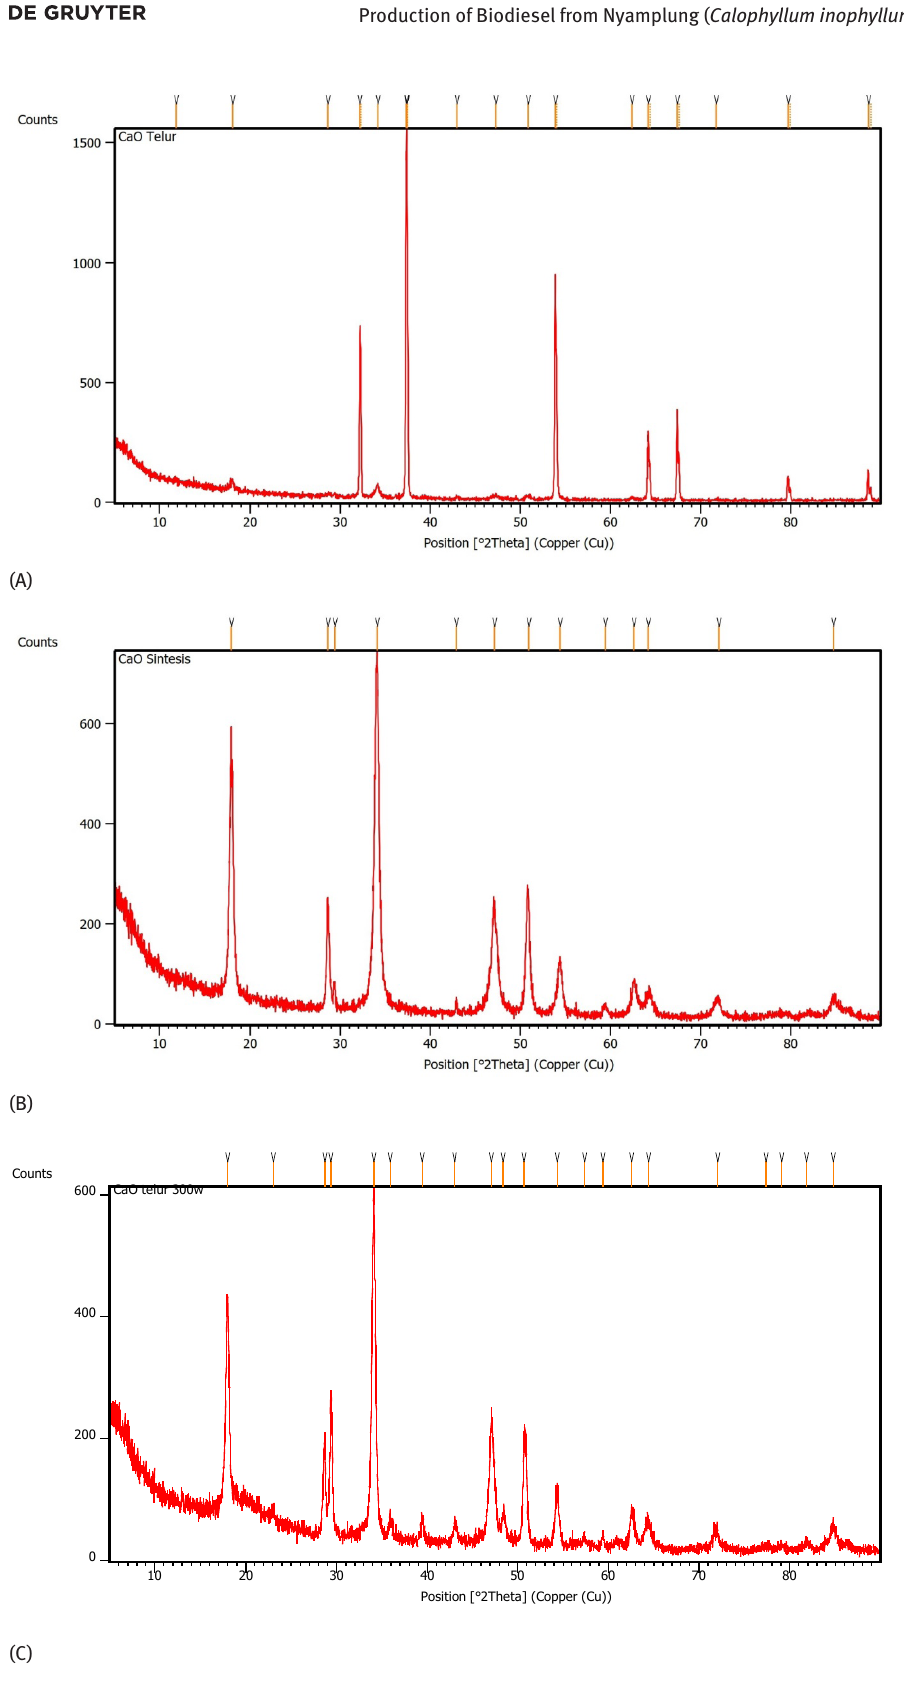
Figure 2: XRD pattern of: (A) CaO eggshell catalyst calcined at 900°C, (B) commercial CaO catalyst, (C) remaining CaO eggshell